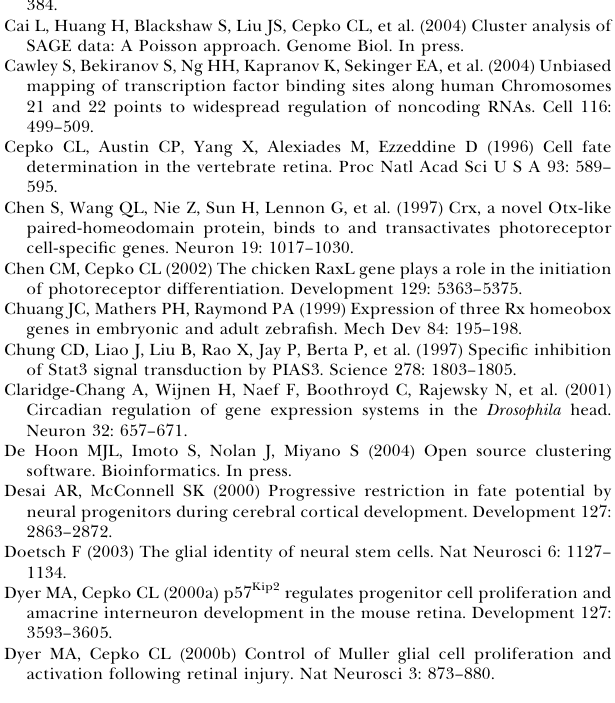
Table S15. Average Distance Analysis of SAGE Tag Clusters Tags present at greater than 0.1% in one or more of the ten wild-type total retina libraries were considered and were normalized to 100,000 for this analysis. The average sum-of-squares within k- means clusters for each number of clusters is shown. The PRE, given by ( Ni (cid:1) N ( i – 5))/ Ni, is also